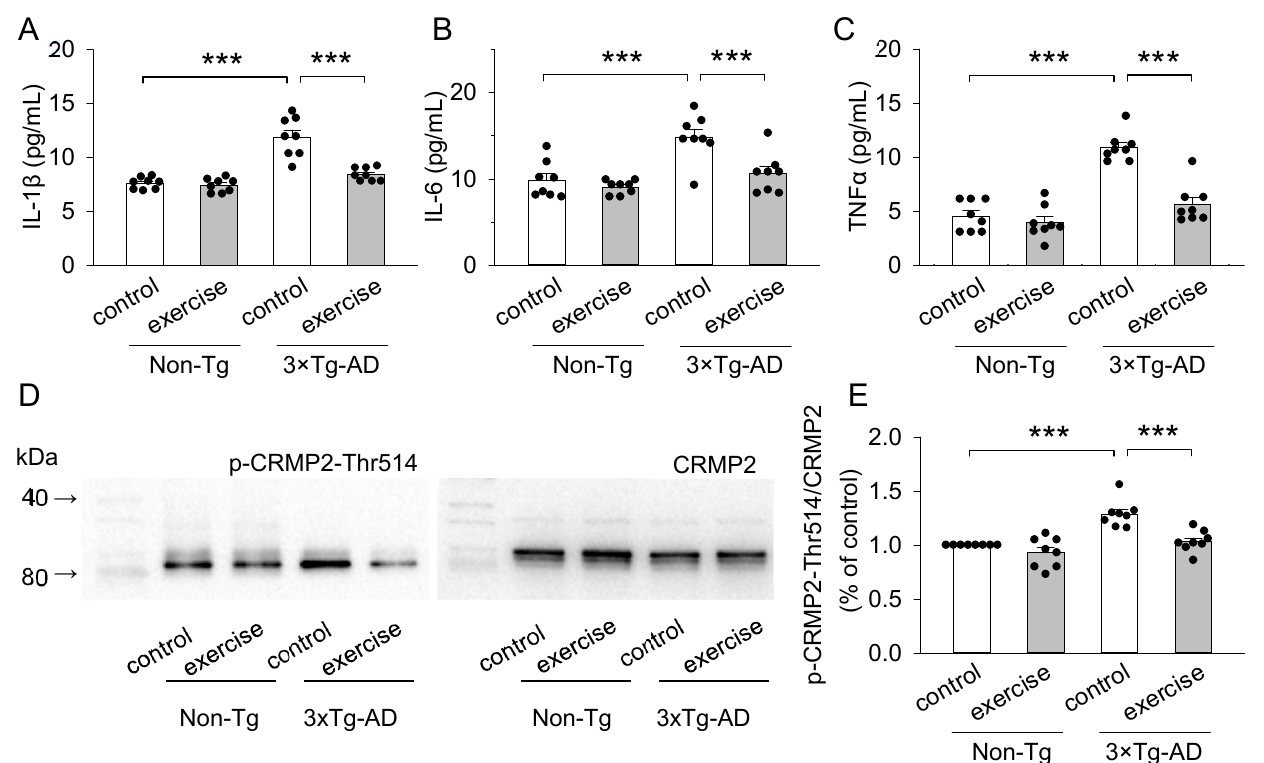
Figure 4. Treadmill exercise decreased the pro-inflammatory cytokines and p-CRMP2 in 3 × Tg-AD mice. ( A – C ) ELISA analysis of IL-1 β ( A ), IL-6 ( B ), and TNF α ( C ) concentrations in the prefrontal cortex. The concentrations of IL-1 β (( A ), *** p < 0.001; n = 8-8), IL-6 (( B ), *** p < 0.001; n = 8-8), and TNF α (( C ), *** p < 0.001; n = 8-8) in the prefrontal cortex were significantly increased in the 3 × Tg-AD control group compared to the non-Tg control group, and these increases were blocked by treadmill exercise pretreatment (*** p < 0.001, n = 8-8). ( D ) Representative western blots for p-CRMP2-Thr514 and CRMP2 in the prefrontal cortex homogenates were prepared from these four groups of mice. ( E ) Quantitative analysis revealed that the levels of p-CRMP2-Thr514/CRMP2 was significantly higher in 3 × Tg-AD mice compared to the non-Tg control group (*** p < 0.001, n = 8-8), and this increase was blocked by treadmill exercise pretreatment (*** p < 0.001, n = 8-8). See Supplementary Figure S4 for uncropped blots. 2.6. Treadmill Exercise Ameliorated Synaptic Transmissi on Dysfunction of the Prefrontal Cortex in 3 × Tg-AD Mice To investigate the effects of treadmill exercise on synaptic transmission in the prefrontal cortex in 3 × Tg-AD mice, we recorded miniature excitatory postsynaptic currents (mEPSCs, Figure 5A–C) and miniature inhibitory postsynaptic currents (mIPSCs, Figure 5D–F) from pyramidal neurons in ex vivo prefrontal cortex slices. Two-way ANOVA revealed that genotype and treadmill exercise had significant main effects on the mean frequency of mEPSCs (genotype: F 1,56 = 11.7, p < 0.001; treadmill exercise: F 1,56 = 11.1, p = 0.002; Figure 5B) and mIPSCs (genotype: F 1,56 = 23.1, p < 0.001; treadmill exercise: F 1,56 = 22.2, p < 0.001; Figure 5E), and the mean amplitude of mEPSCs (genotype: F 1,56 = 33.5, p < 0.001; treadmill exercise: F 1,56 = 20.8, p < 0.001; Figure 5C) and mIPSCs (genotype: F 1,56 = 80.0, p < 0.001; treadmill exercise: F 1,56 = 21.3, p < 0.001; Figure 5F), but there was no significant interaction between genotype and treadmill exercise on the mean frequency of mEPSCs (genotype × treadmill exercise interaction: F 1,56 = 0.07, p = 0.795) and mIPSCs (genotype × treadmill exercise interaction: F 1,56 = 1.6, p = 0.215), and the mean amplitude of mEPSCs (genotype × treadmill exercise interaction: F 1,56 = 0.8, p = 0.368) and mIPSCs (genotype × treadmill exercise interaction: F 1,56 = 0.4, p = 0.519). Tukey’s post hoc tests